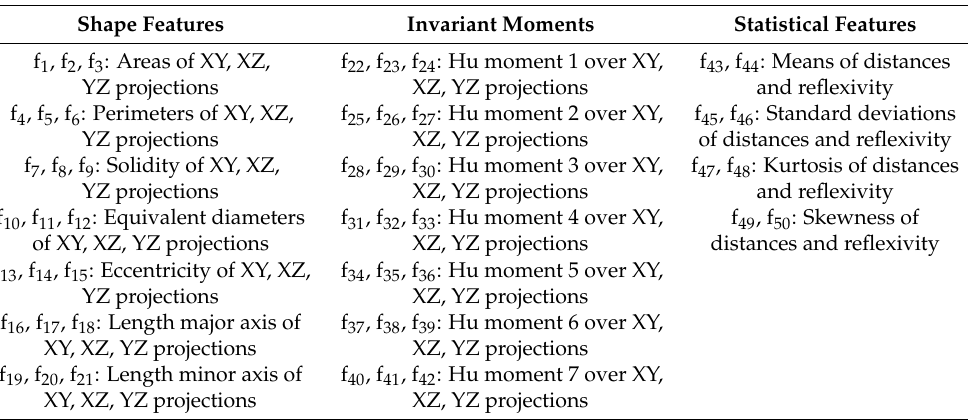
Table 1. Feature vector